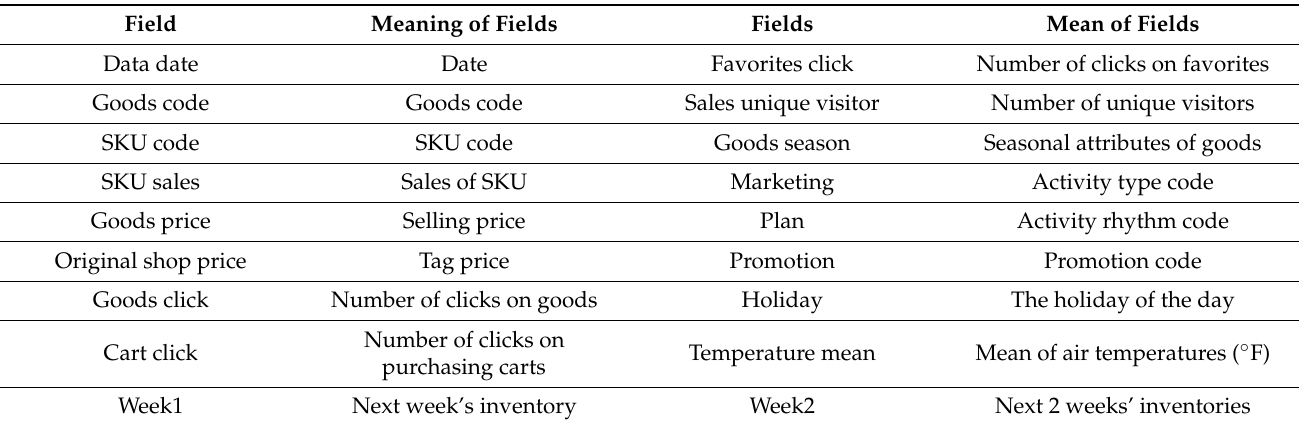
Table 2. The description of